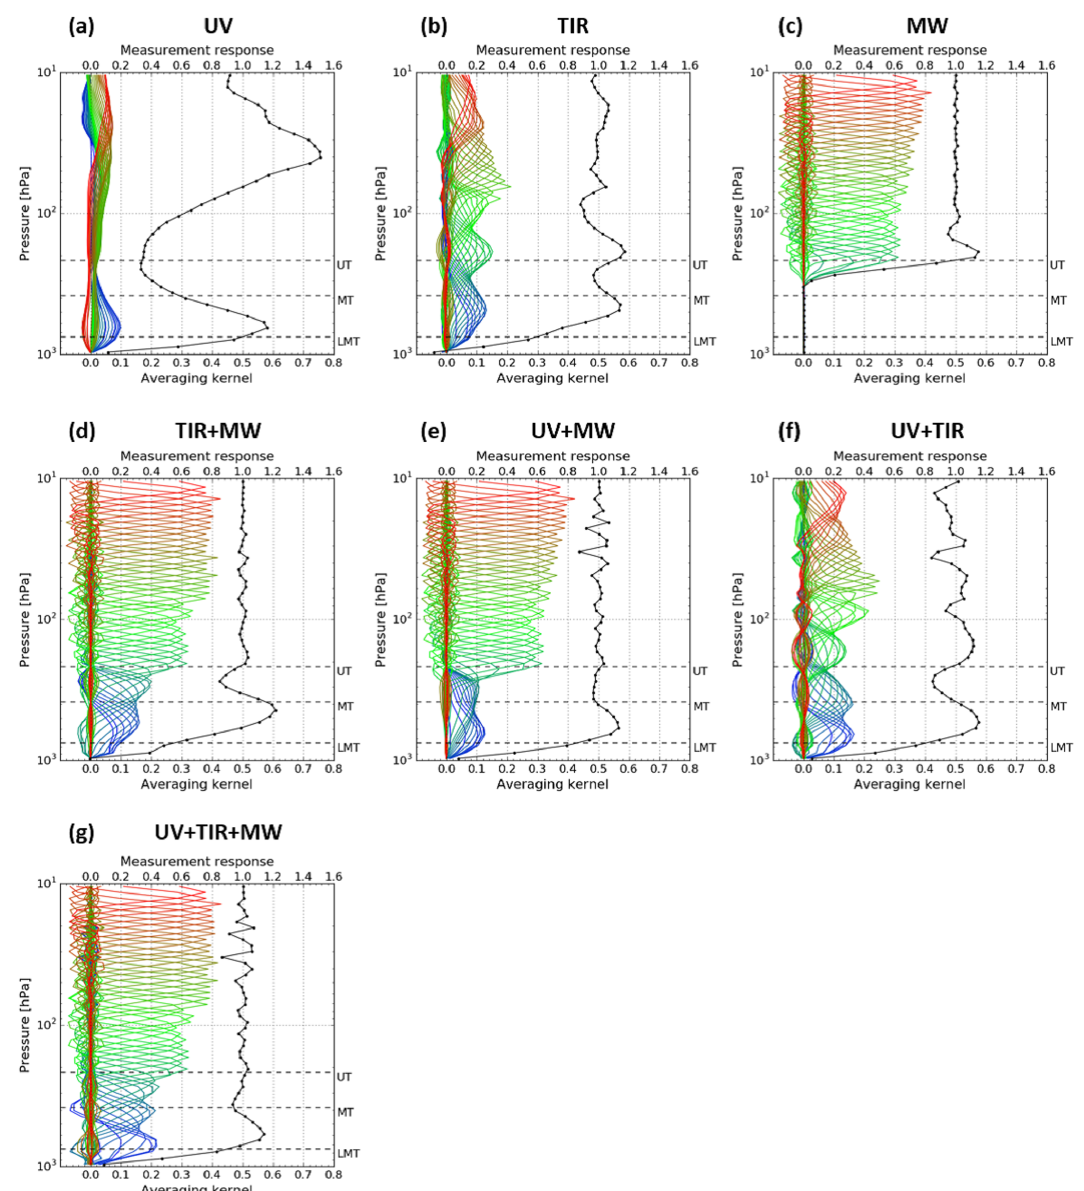
Figure 6. Same as Fig. 5 but for profile no. 12 (less ozone in LMT, CEC in December